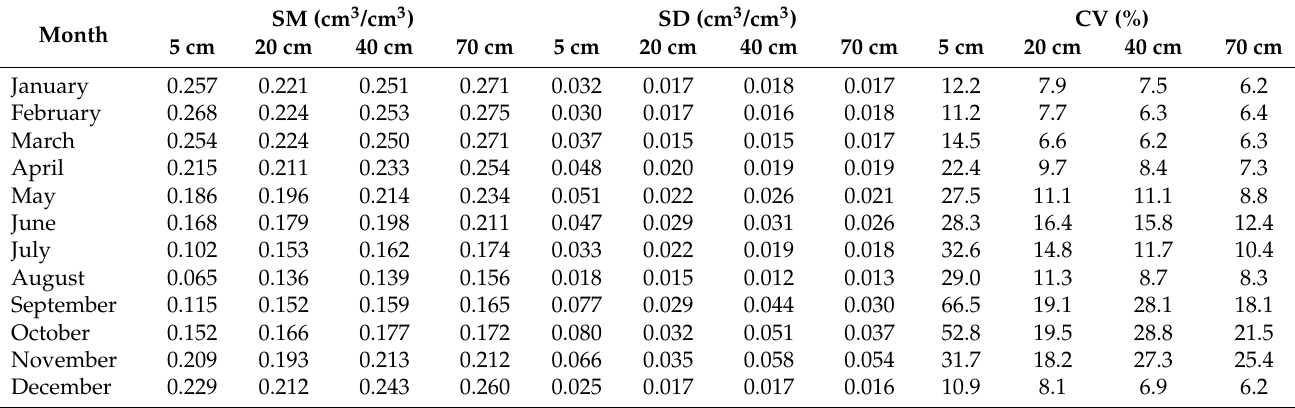
Table 4. Soil moisture (SM) variations with depth for the period